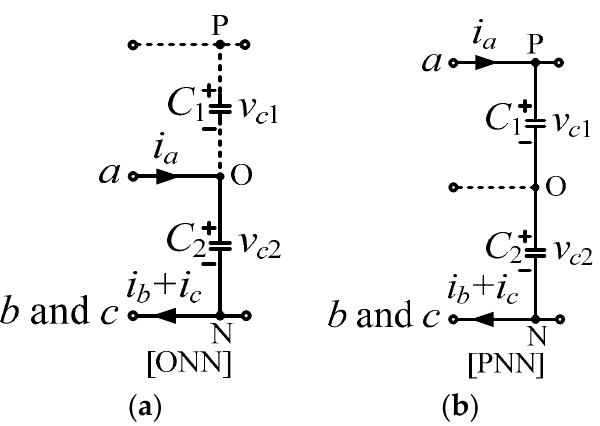
Figure 4. Capacitor current flow of sector 1 with switching status: ( a ) (ONN); ( b ) (PNN). Based on the same approach used in sector 1, relationships between the capacitor voltage difference and the sign of the offset voltage can be established in the other sectors from 2 to 12 in Figure 2. The sign of the offset voltage to retain the balance of the capacitor voltage can be defined,